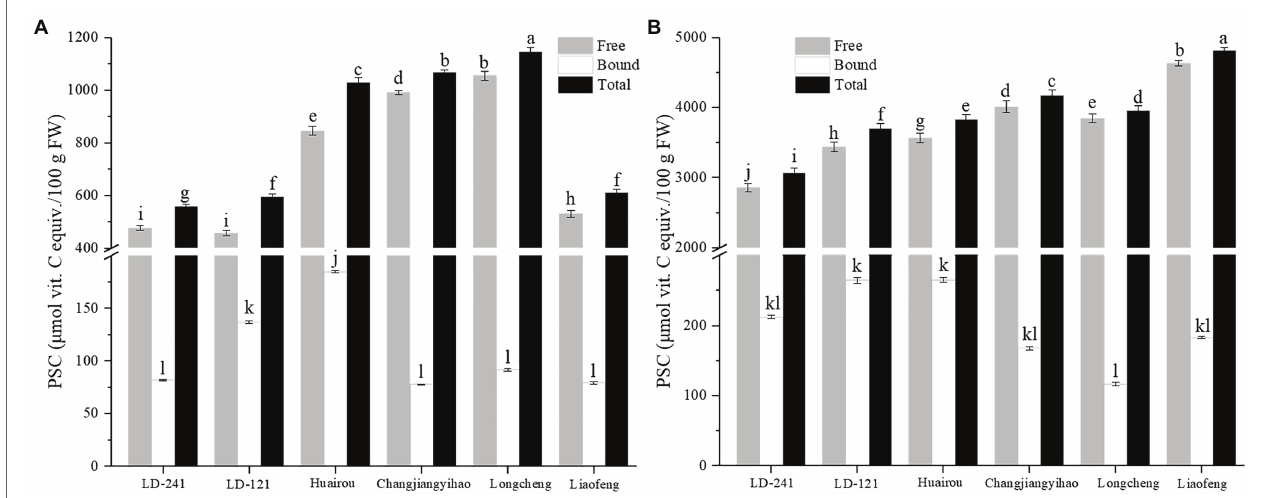
FIGURE 4 | PSC values of flesh extracts (A) and peel extracts (B) of six kiwi berry varieties (mean ± SD; n = 3). Bars with different letters differ significantly ( p < 0.05).